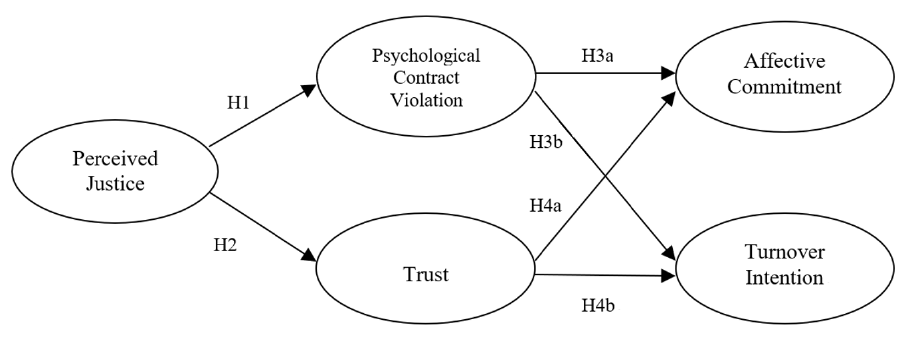
Figure 1. Research model .